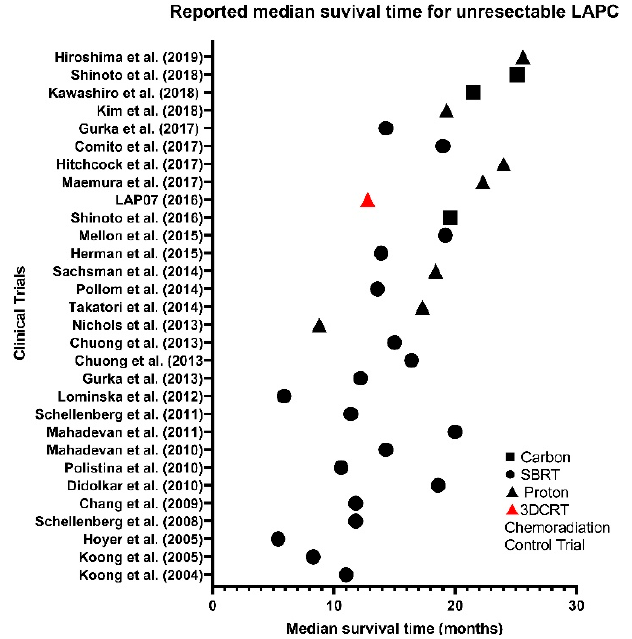
Figure 3. Reported median survival time (MST) for unresectable LAPC across SBRT ( ● ), proton ( ▲ ) and carbon ( ∎ ) clinical trials compared to 3D conformal chemoradiation ( ▲ ) control trial.